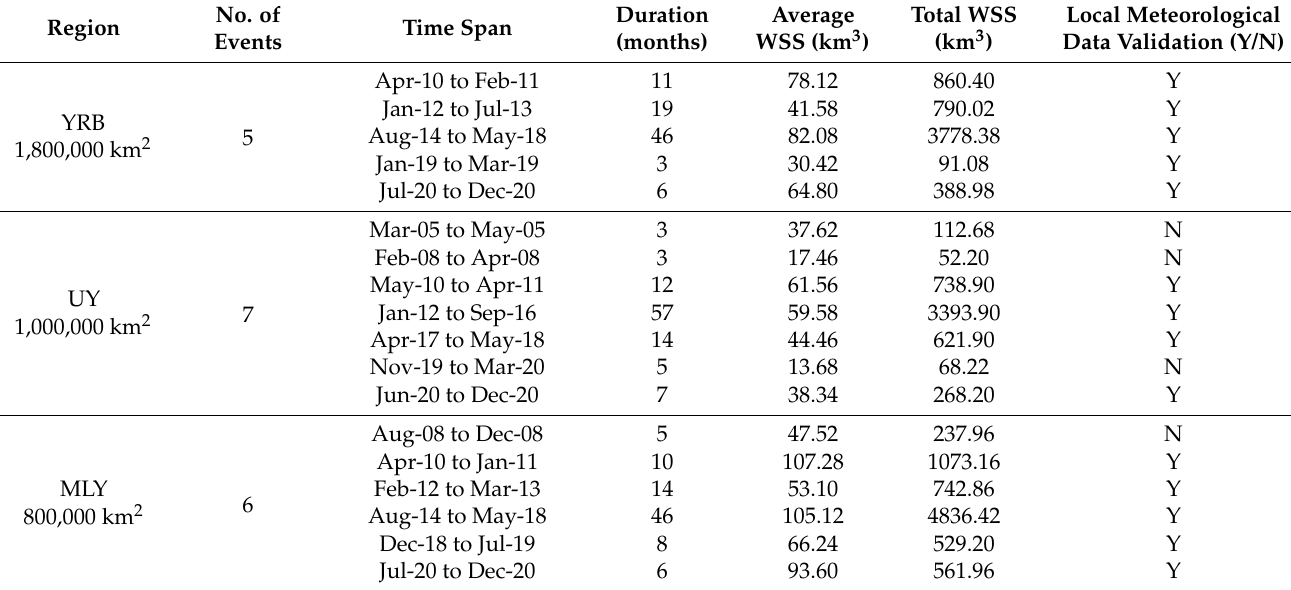
Table 2. Summary Table of flood